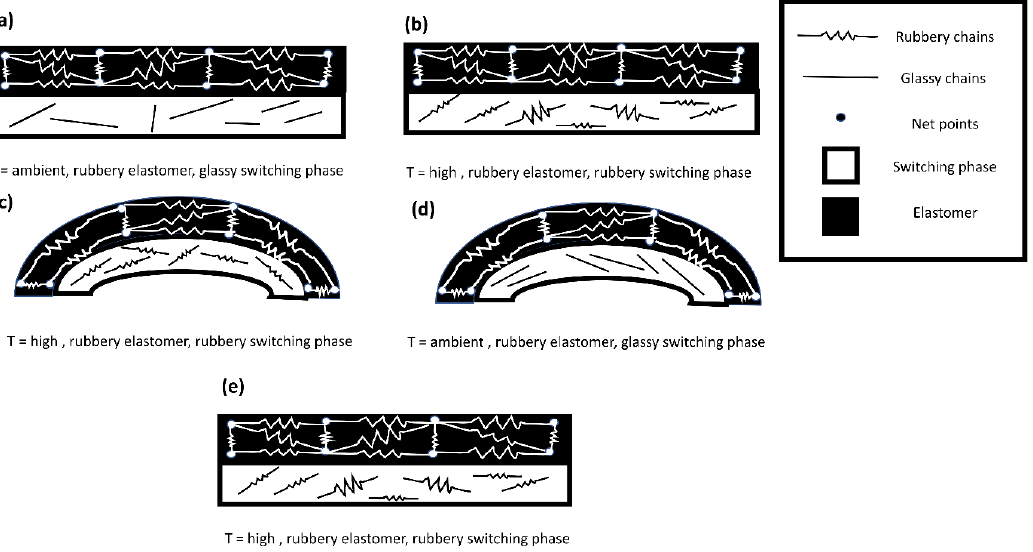
Figure 6. Schematic of samples during the shape memory cycle: ( a ) as-printed condition, ( b ) after heating, ( c ) after deformation, ( d ) after cooling, ( e ) recovery step. Table 2. Results of cyclic shape memory